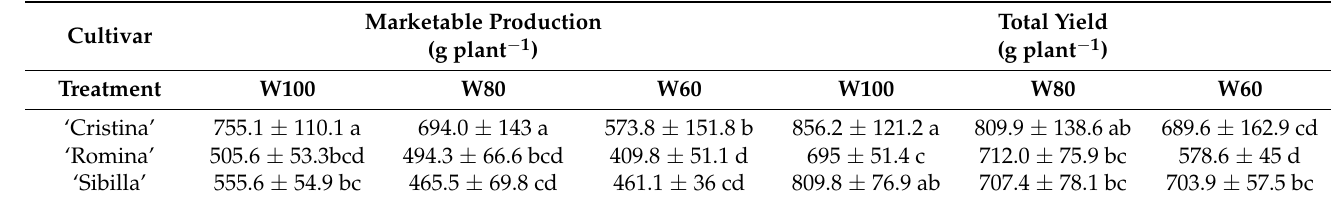
Table 11. Effects of water availability on marketable production and total production in different strawberry cultivars. Values with the same lowercase letter for the same parameter were not statisti- cally different for Fisher’s LSD test ( p < 0.05). Values are expressed as means of two years (2017–2018) ± standard deviation